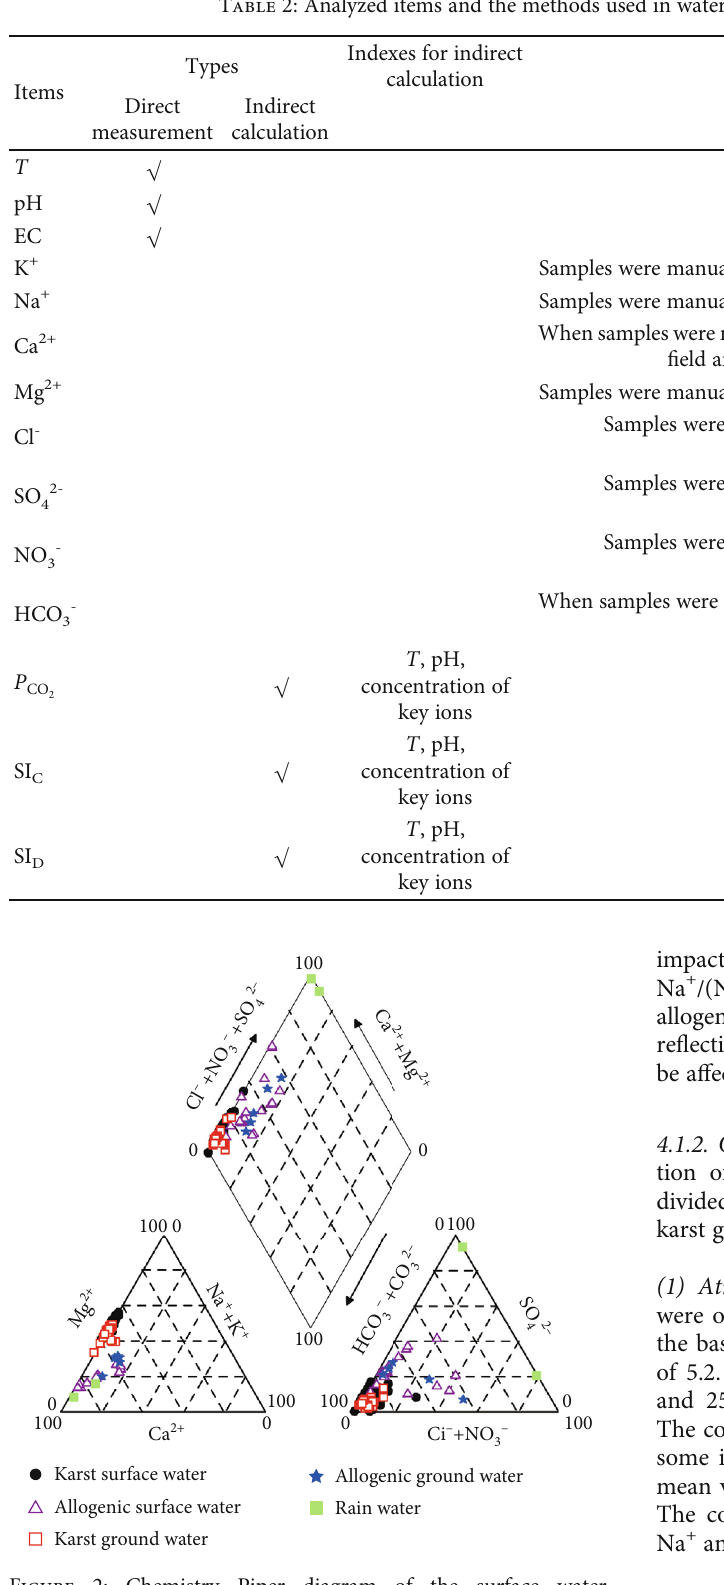
Figure 2: Chemistry Piper diagram of the surface water, underground water, and rain water in Shanmuhe